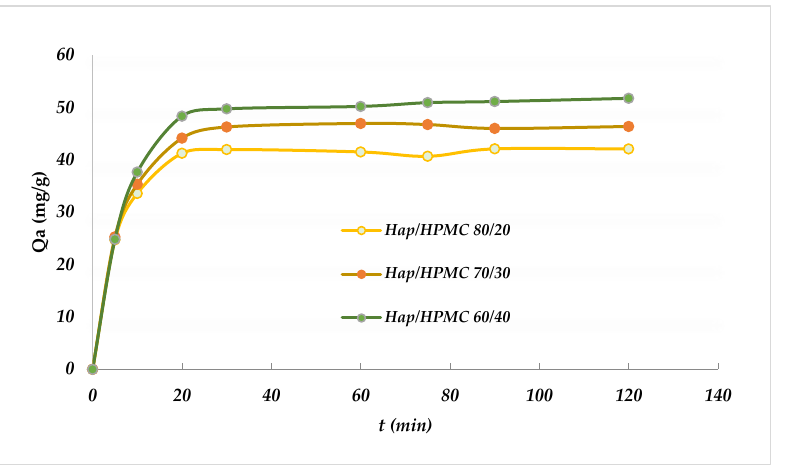
Figure 13. Evolution of the MB adsorbed quantity ( Q a ) as a function of time, [MB] = 53.4 mg/L, pH = 7 and T = 25 ± 2 °C, adsorbent 10 mg, V rot = 250 rpm.